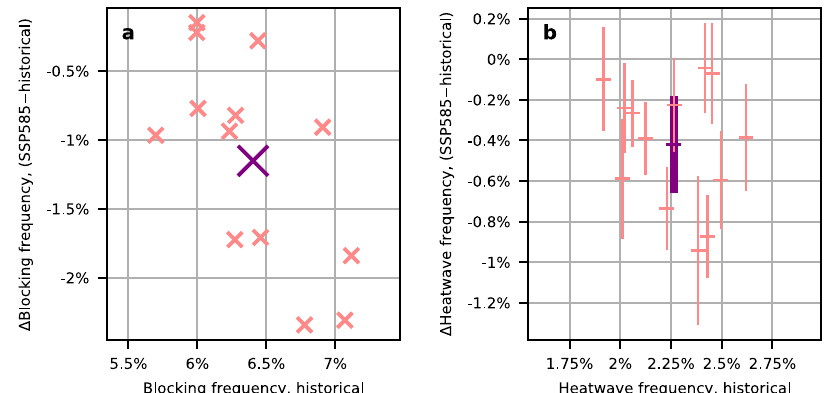
Fig. 2 The decrease of blocking alone is projected to give a one- fi fth decrease in heatwave frequency. a Projected change in blocking frequency versus historical blocking frequency. b Projected change in heatwave frequency contributed by a change in blocking frequency alone, versus historical heatwave frequency, with 1 σ error bars of 10-year-mean heatwave frequency (see the subsection “ Uncertainty estimate ” ). Projections from 13 models are plotted in pink, and a simple arithmetic multi-model mean is plotted in purple. The one- fi fth decrease in heatwaves is seen by comparing − 0.4% on the y -axis to 2.3% on the x -axis ( b